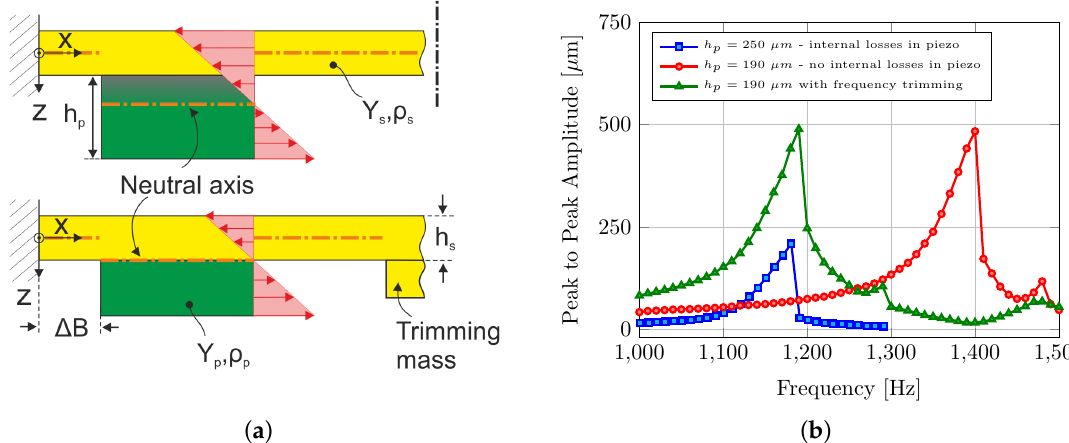
Figure 6. ( a ) Effect of piezo-thickness h p on the non-homogenous strain distribution (solid arrows) and neutral axis position (dotted-dashed line). ( b ) Frequency sweeps near the first resonance frequency of the actuator. All results were measured at an electric field strength of 0.72 kV/mm.